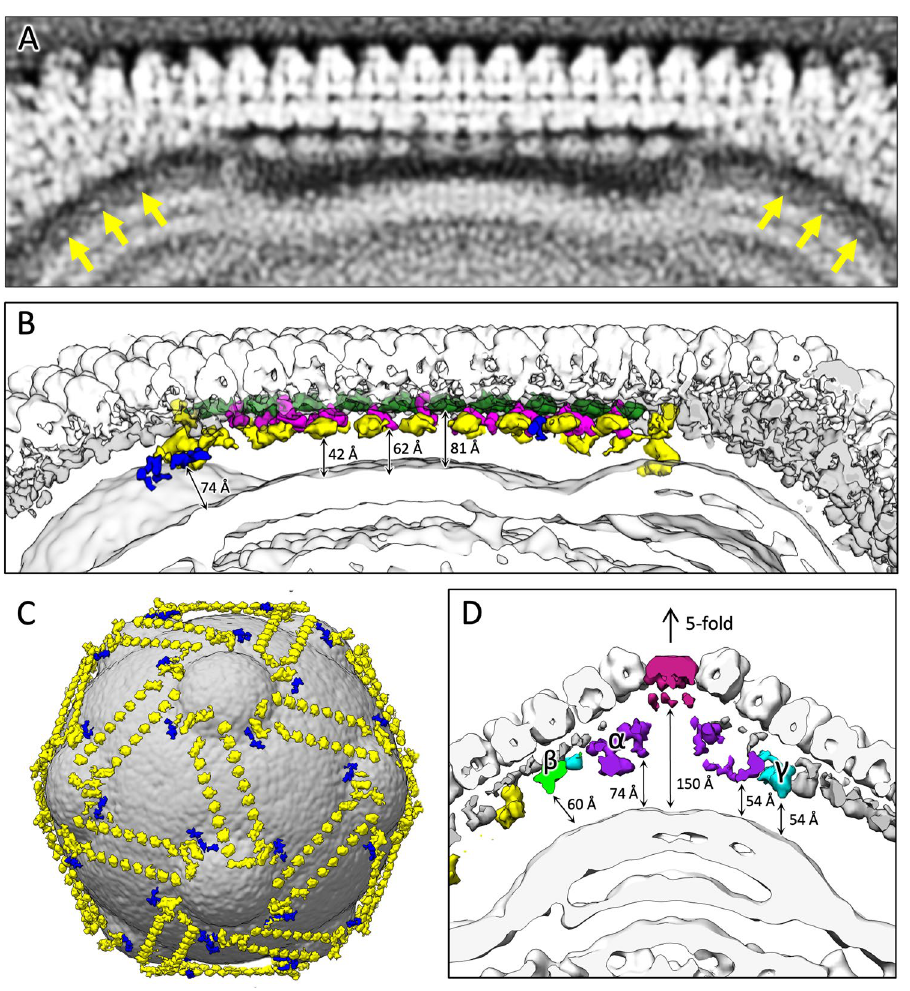
Figure 5. Examination of the scaffold protein component network between the internal membrane and capsid shell. ( A ) Slab density of the tokyovirus capsid along the trisymmetron interface showing the innermost layer of the mCP network. Arrows indicate weak densities connecting the vertex of the capsid and the internal membrane extrusion. ( B ) Isosurface view of the mCP components coloured as in Fig. 4 (GlC; green, ZpC; hot pink, ScPC; yellow, SuC; royal blue) and with distances from the internal membrane to the components indicated by arrows. ( C ) The tokyovirus internal membrane with ScPCs (yellow) and SuC (royal blue) network overlaid. ( D ) Focussing on the pentasymmetron at the fivefold axis, representing distances from the internal membrane extrusion to PC-α, β, γ (purple, light green, and cyan) and the penton (red purple). The isosurface is shown at 2